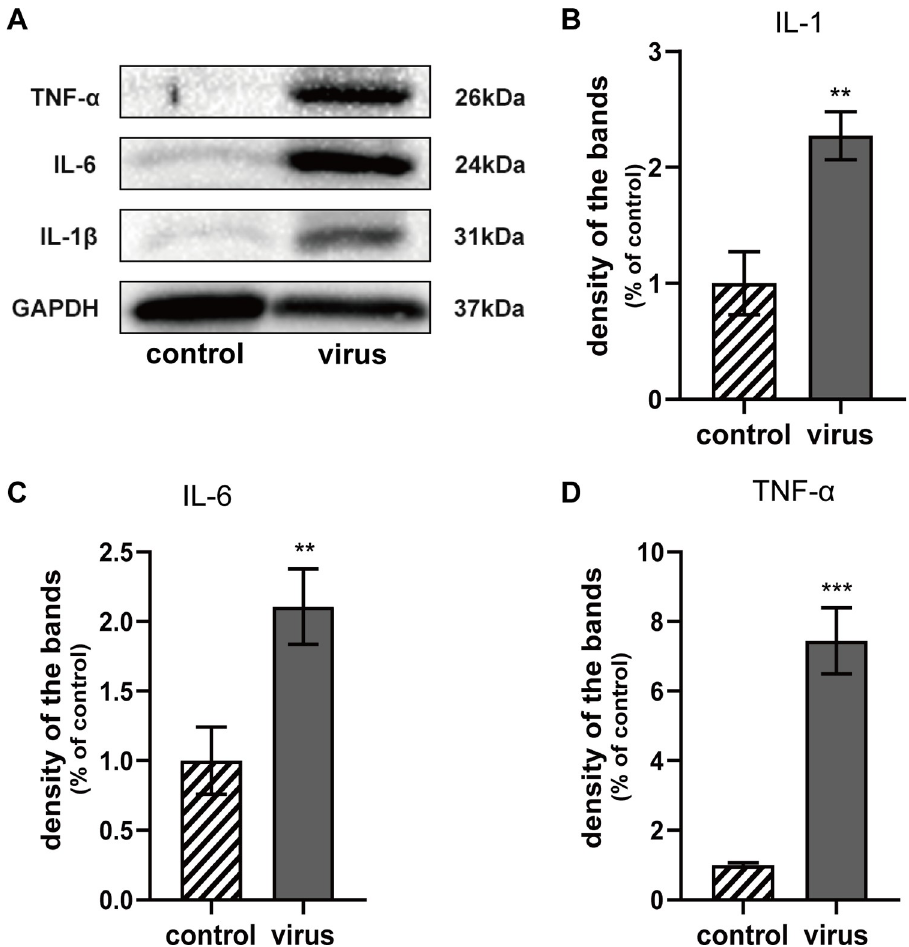
Fig 6. Western blot analysis of Inflammatory cytokines expression levels. (A) Inflammatory cytokines were determined by Western blot; (B) Relative expression of IL-1 β between two groups; (C) Relative expression of IL-6 between two groups; (D) Relative expression of TNF- α between two